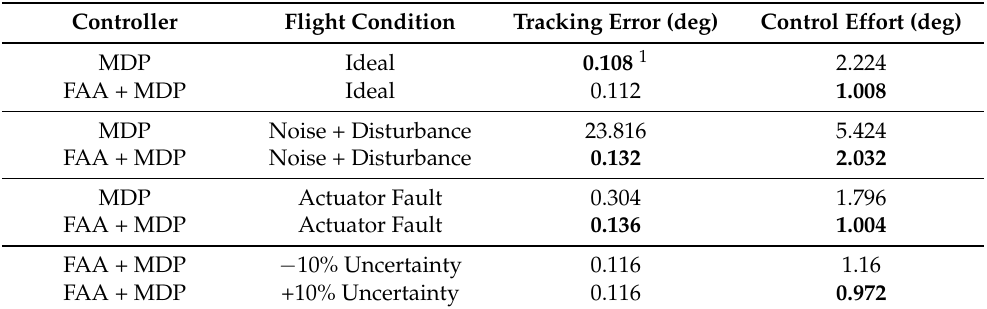
Table 7. Tracking error and control effort of two methods in variable θ des tracking in different flight